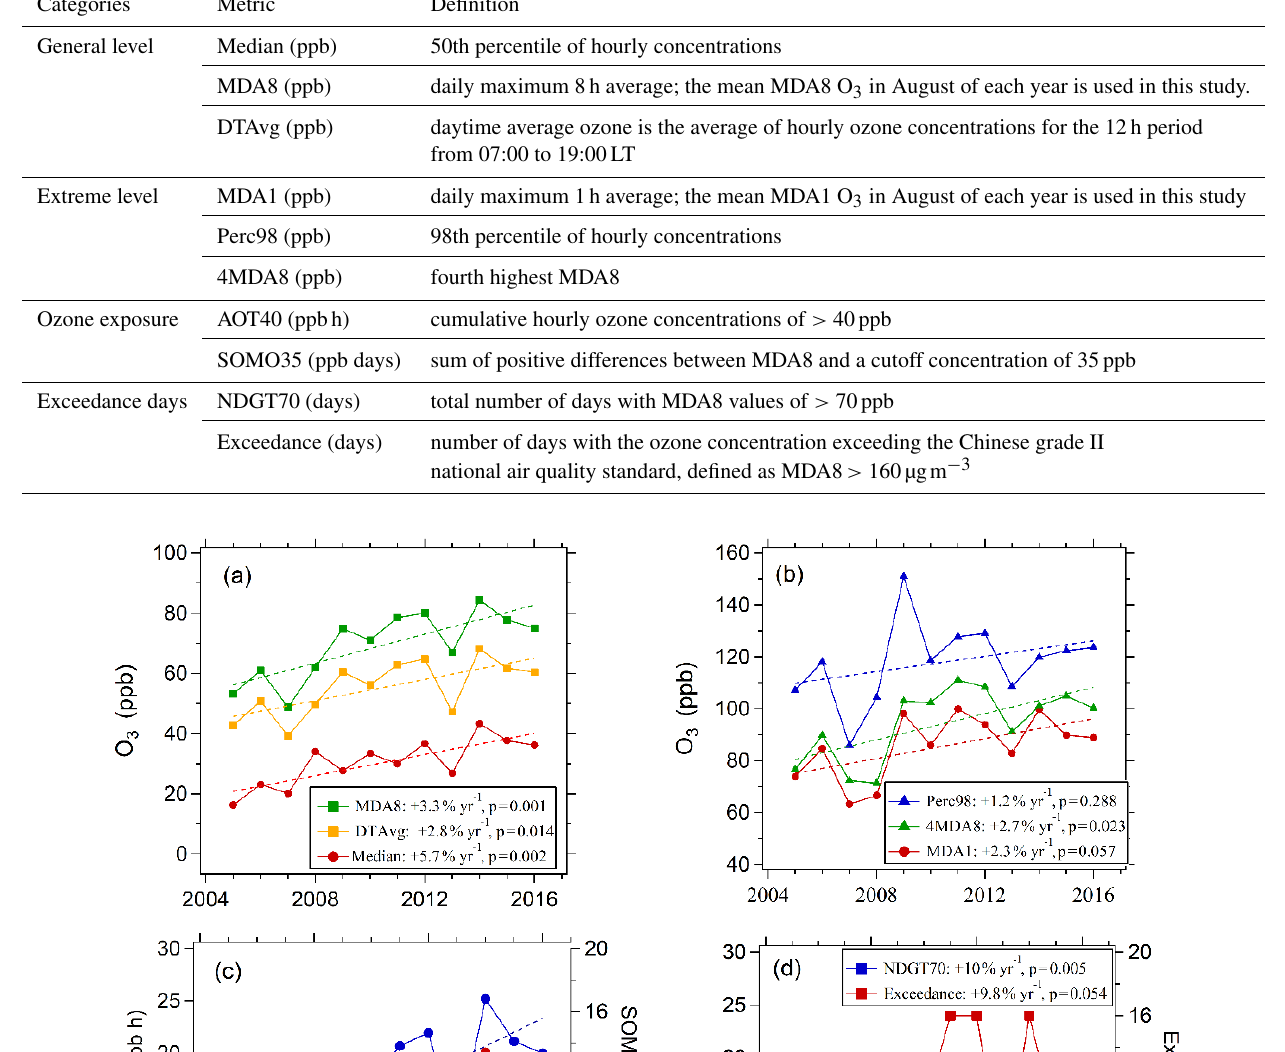
rate of 1 . 4 ± 0 . 6 ppbv (1 . 9 ± 0 . 8 %) yr − 1 , due to the decrease in NO x concentrations (Fig.